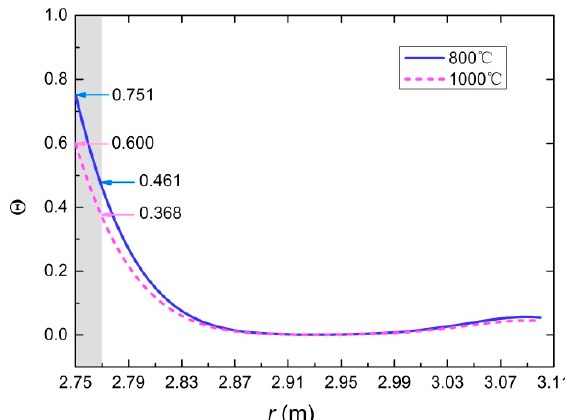
Figure 13. Dimensionless temperature distribution of tunnel lining at the spalling moment.